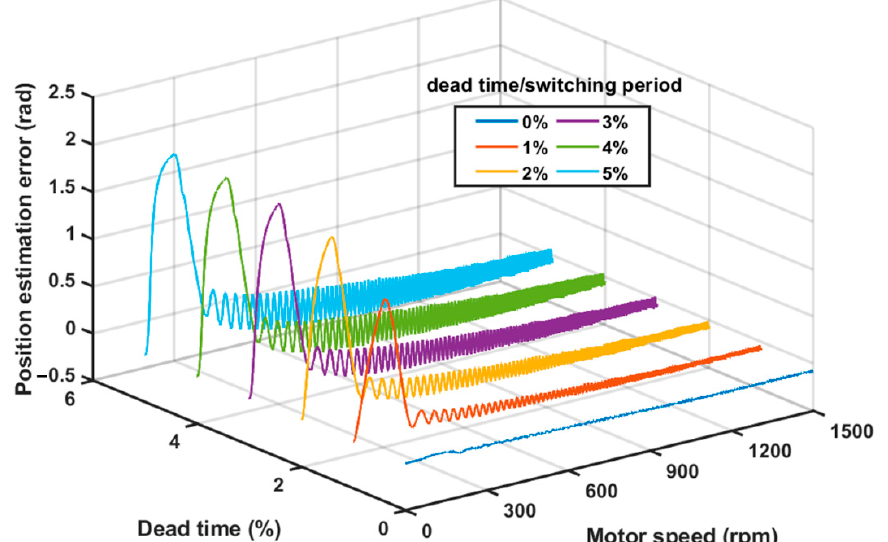
Figure 6. Rotor position estimation error of the extended flux-based observer with different dead time.